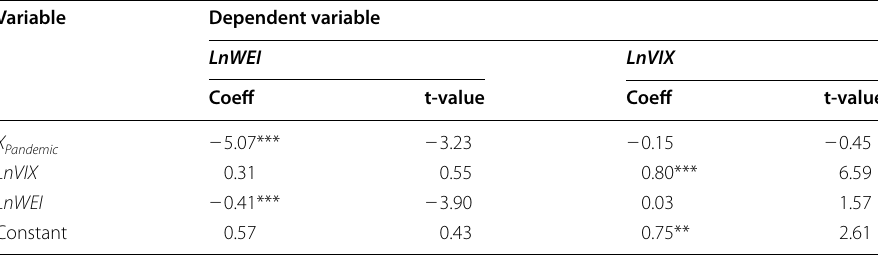
as an exogenous variable Pandemic